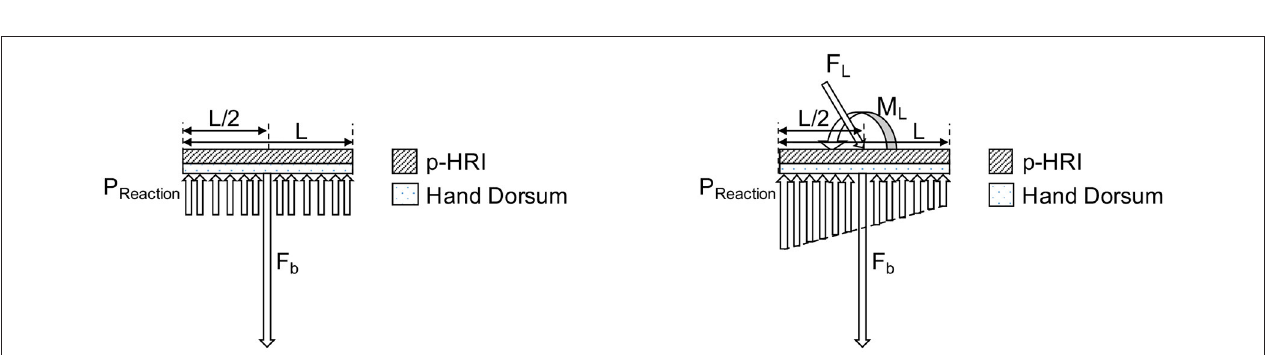
FIGURE 7 | (Left) Hand dorsum and simplified PHRII with uniform stiffness, bias force ( F b ), applied using straps and approximated as a point load at the center, and reaction pressure ( P reaction ). (Right) Modeling all compliant elements between the human reference structure (our skeleton) and the rigid links of the robot. The stiffness of the hand dorsum ( k dorsum indicating the orange springs) and the PHRII ( k pHRI indicating the yellow springs) behave as a set of viscoelastic springs in series.